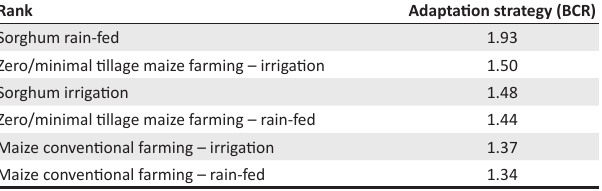
TABLE 6: Benefit-cost ratios for the selected adaptation strategies for Alice.